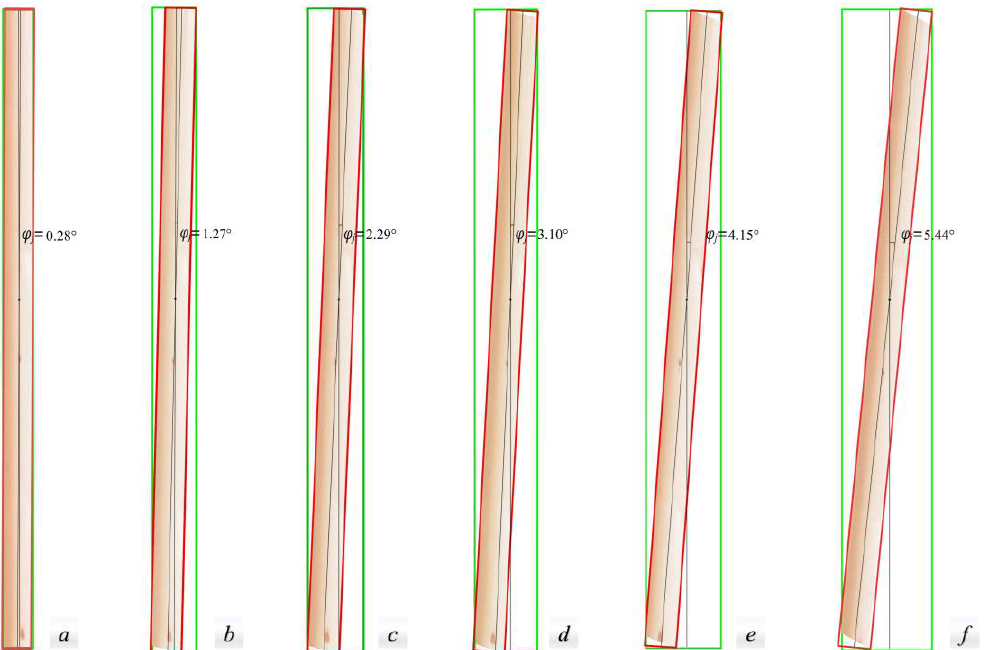
Figure 9. Fitting of the minimum enclosing rectangle before and after the rotation of the dimension lumber with different conveying deflection angles. ( a ) deflection angle φ j = 0.28°; ( b ) deflection angle φ j = 1.27°; ( c ) deflection angle φ j = 2.29°; ( d ) deflection angle φ j = 3.10°; ( e ) deflection angle φ j = 4.15°; ( f ) deflection angle φ j = 5.44°.